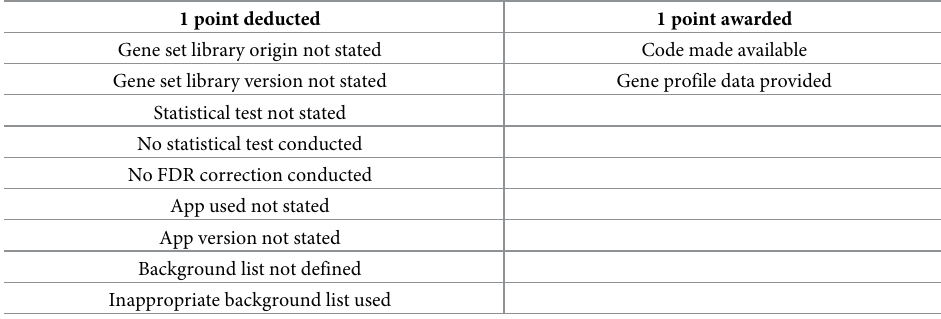
Table 2. Scoring schema.